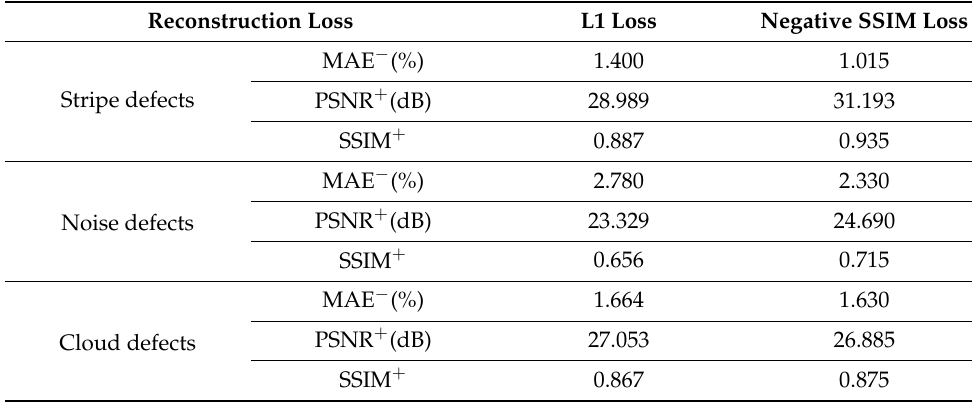
Table 9. Inpainting Quality Comparison of Different Reconstruction